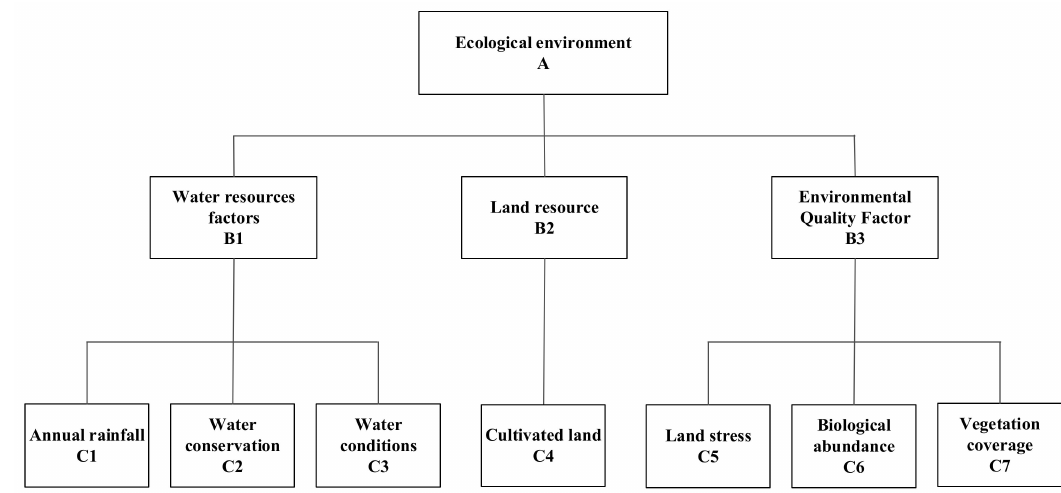
Figure 8. Hierarchical structure of social and economic bearing capacity evaluation.